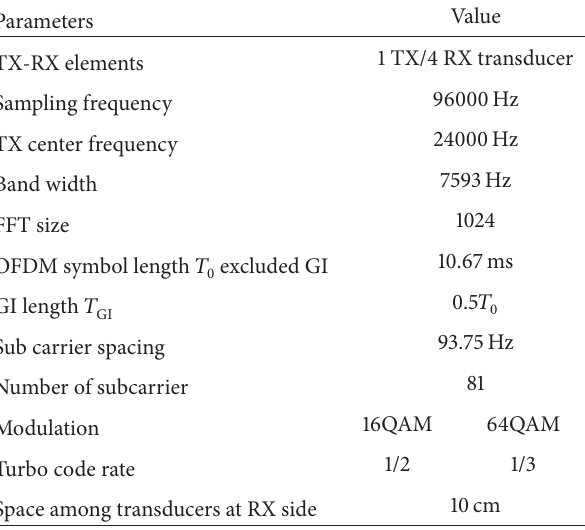
Table 1: Our system